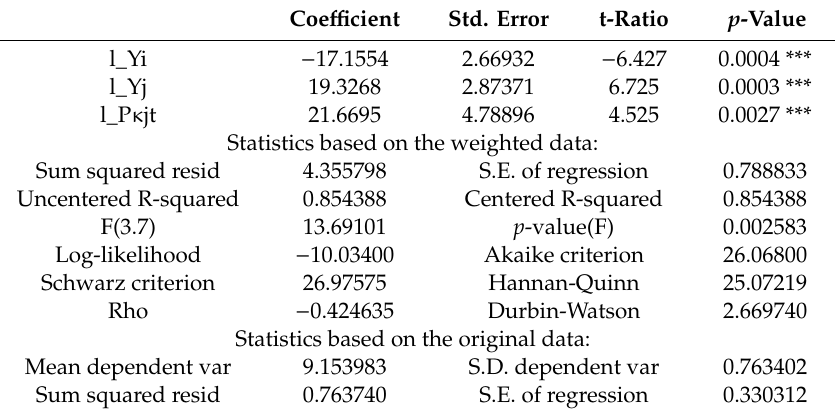
Table 8. FGLS estimation of Croatian tourist consumption in Hungary—final model. Model 5: FGLS, using observations 2009–2018 (T = 10); dependent variable: l_TXij; variable used as weight: l_Dt.